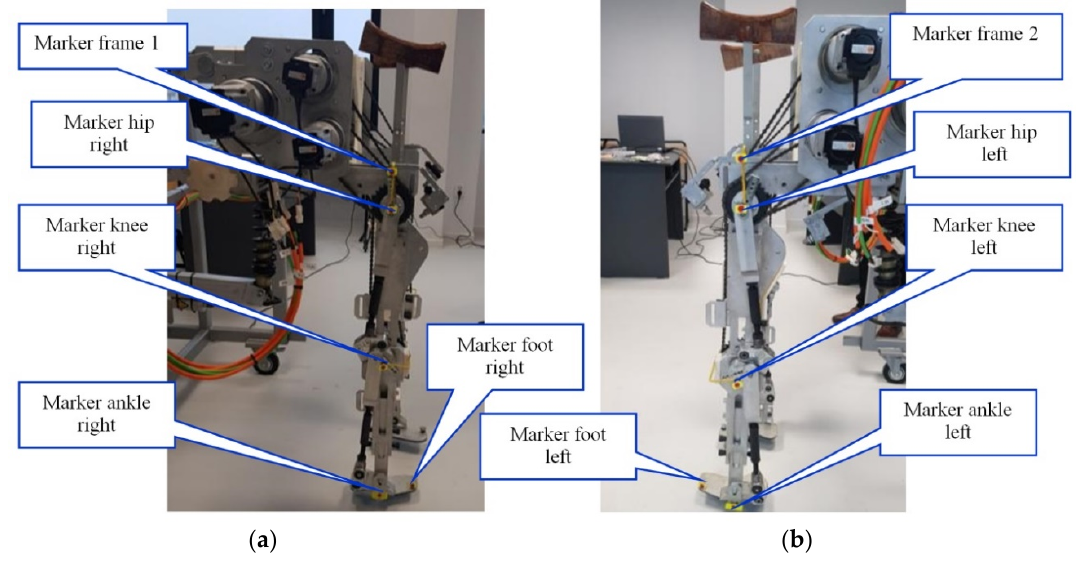
Figure 23. Markers’ positions for the exoskeleton prototype experimental tests: ( a )—right lower limb; ( b )—left lower limb.